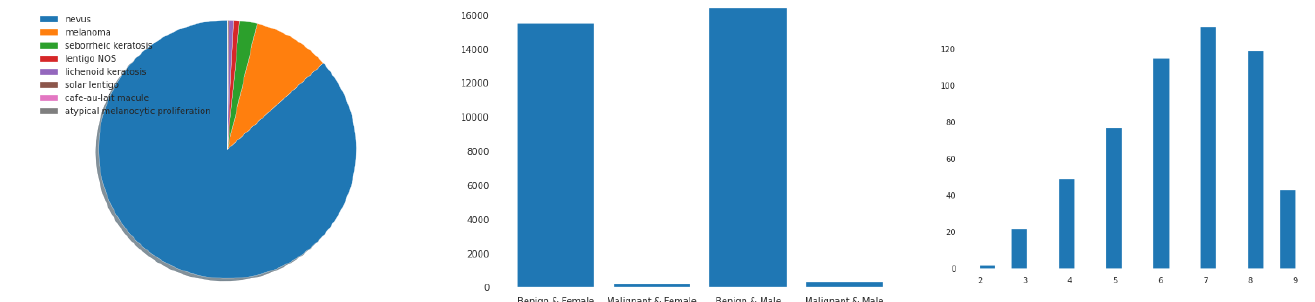
Figure 2. A visual example of a selection of region-of -interests (ROIs) from PSLs lesions after auto- Figure 3. Distribution of samples in the ISIC-2019 and ISIC- 2020 datasets according to patients’ his- matically selecting from centroid position. tory and type of pigmented skin lesions (PSLs). Table 2. Number of images in each class, which were selected from the HAM10000, ISIC-2019, and ISIC-2020 datasets.